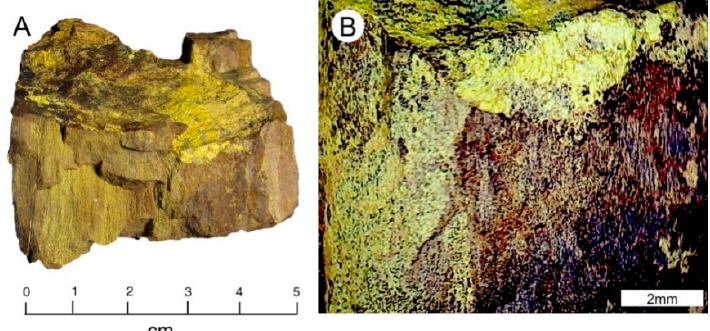
Figure 18. Silicified wood containing uranium and vanadium, Monument #2 Mine, Monument Valley, AZ. ( A ) Tyuyamunite coatings occur in fracture plane surfaces, and within silicified wood tissue. ( B ) Reflected light photomicrograph.